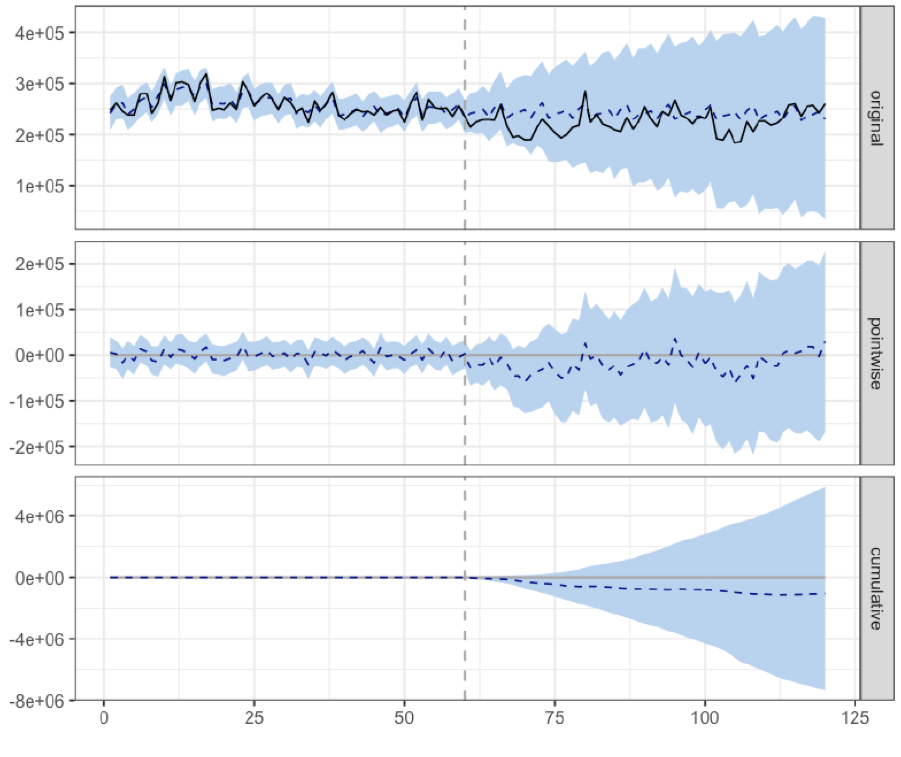
Figure 6. The probabilistic forecasts, the pointwise difference between observed and counterfactual (forecast), and the cumulative impact for treatment group